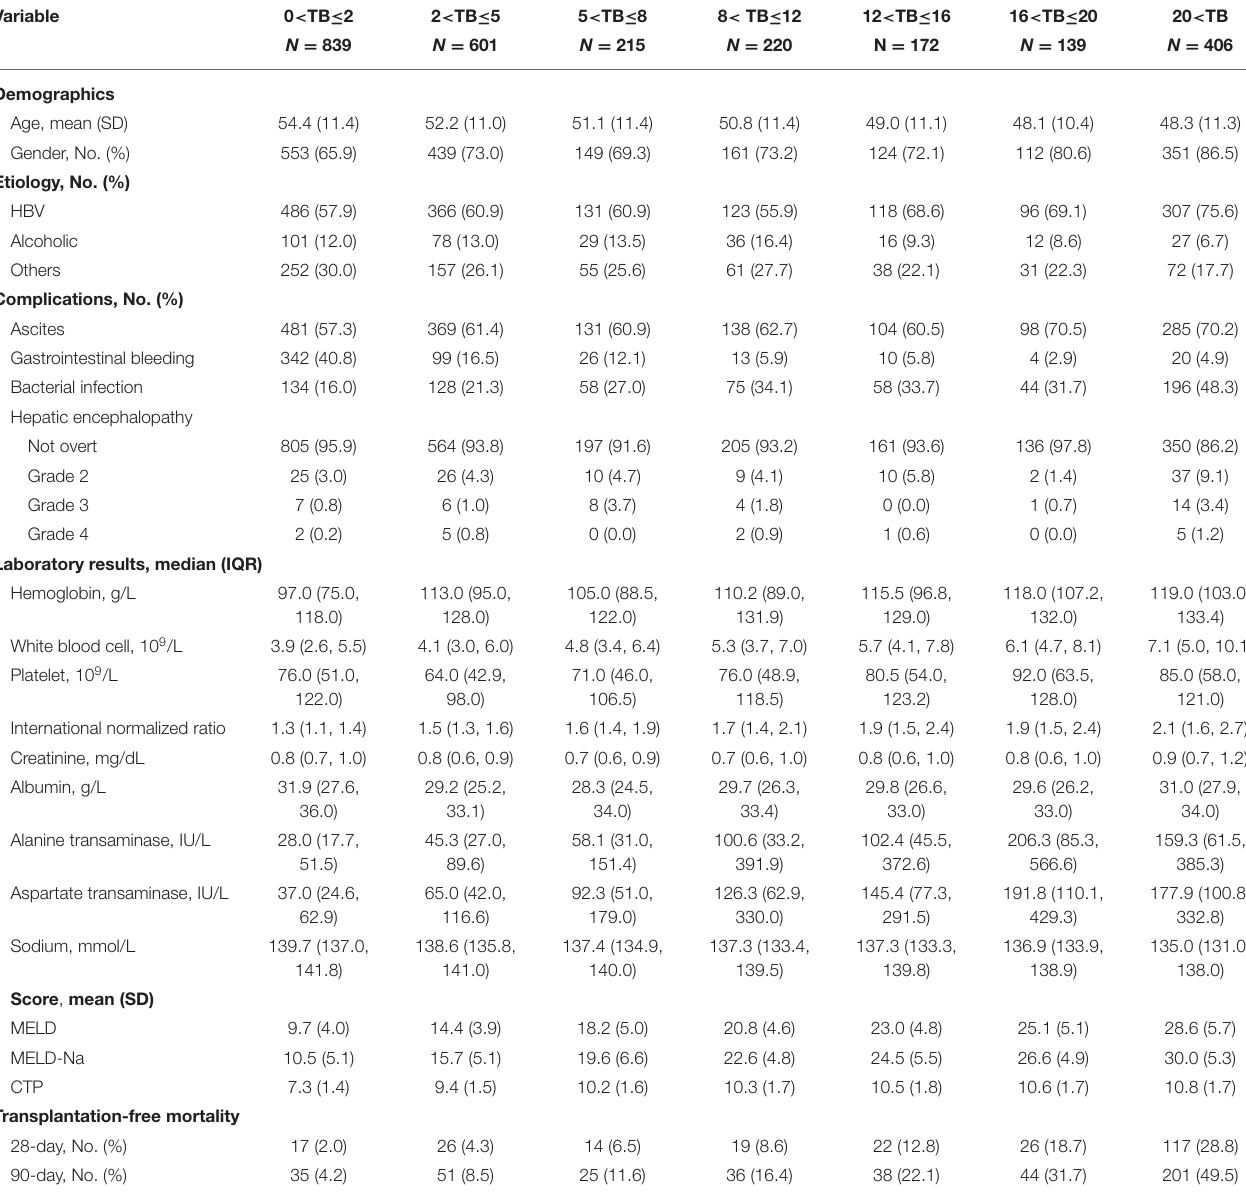
TABLE 1 | Comparison of baseline characteristics of patients with cirrhosis based on different level of total bilirubin (mg/dL) at admission.